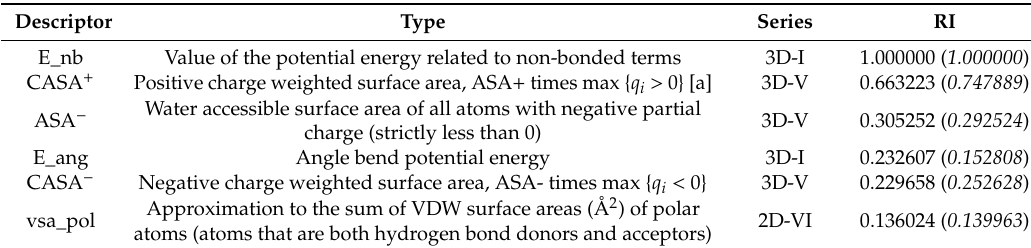
Table 1. Selected descriptor and related relative importance (RI) values based on model A and model B (in italic)